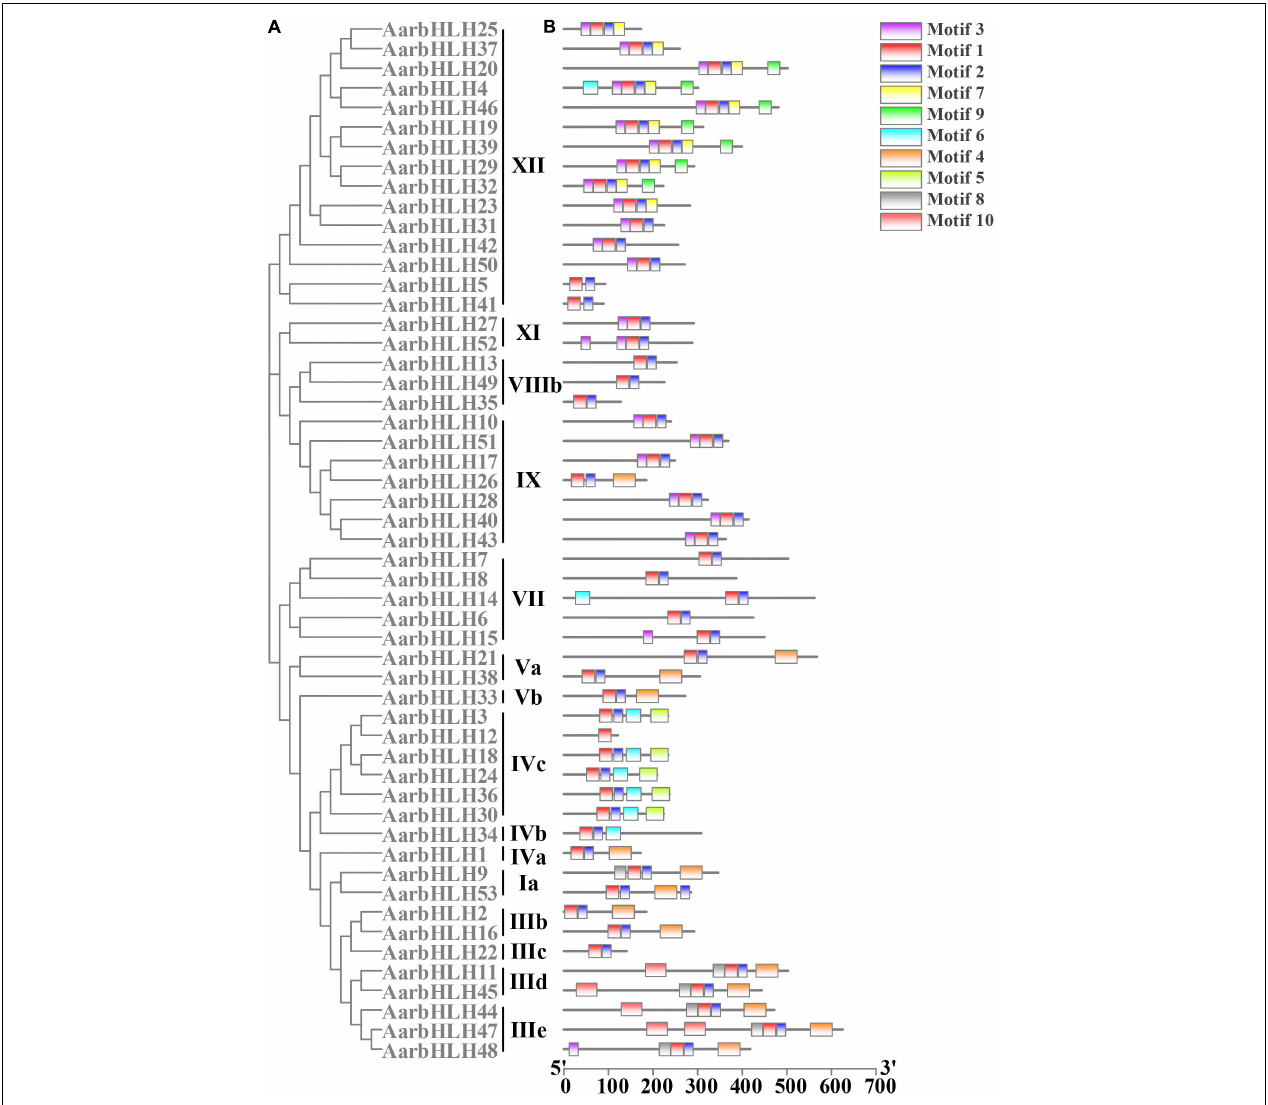
FIGURE 3 | Phylogenetic relationships and conserved motifs analysis of AarbHLH proteins. (A) Neighbor-joining phylogenetic tree of AarbHLHs (bootstrap values for 1000 replicates). (B) Distribution of conserved motifs in AarbHLH proteins. The colored boxes represent different motifs. The box length represents motif